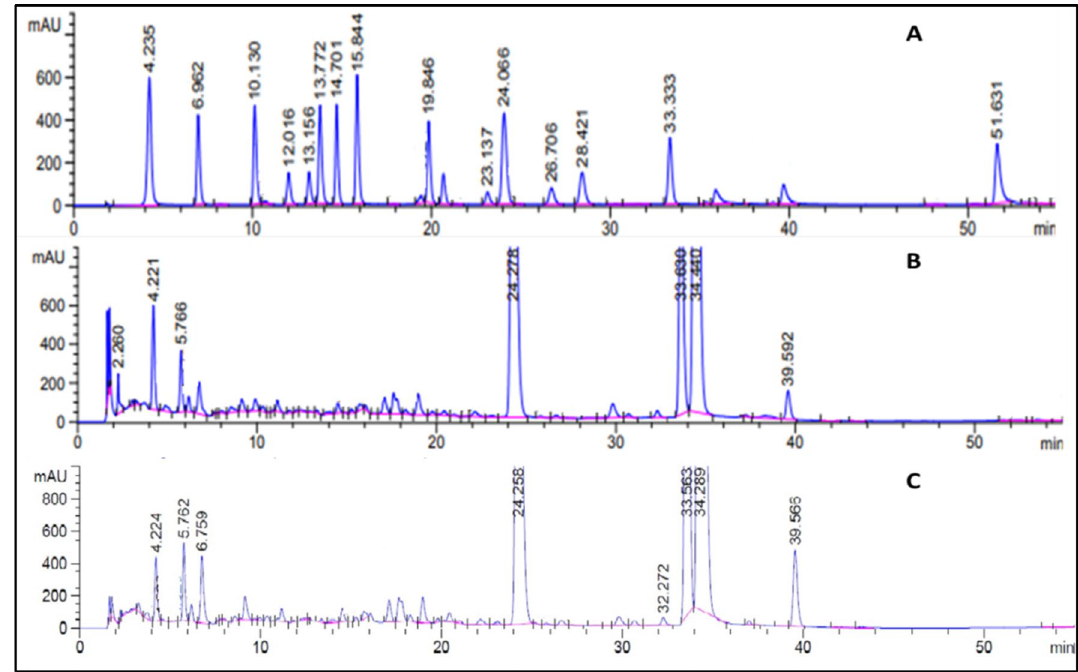
Fig. 5 The chromatogram of standards ( A ), non‑fermented ( B ), and fermented cinnamon extract ( C